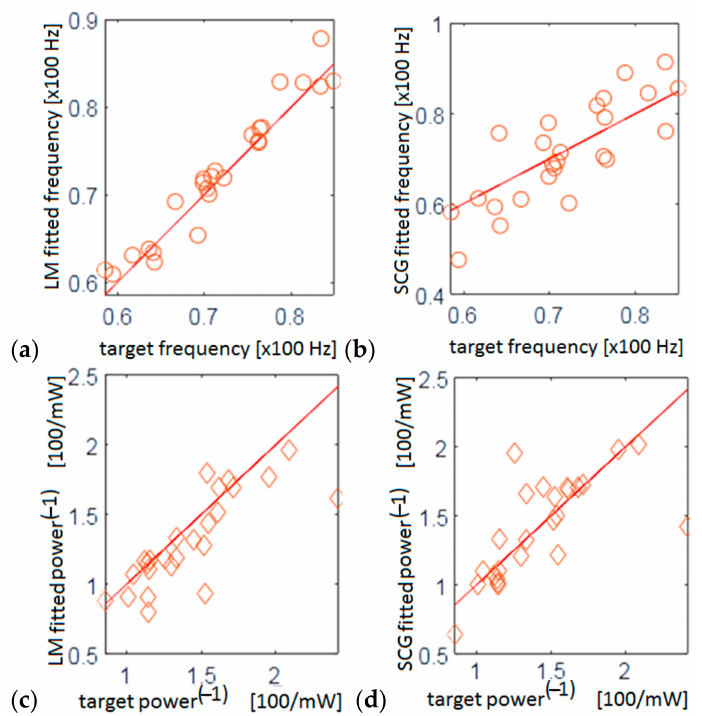
Figure 15. Performances of the obtained ANN functions fed with unknown data. LM refers to the Levenberg–Marquardt algorithm, SCG refers to scaled conjugate gradient algorithm, red line is y = x, the ideal correlation between the true and fitted